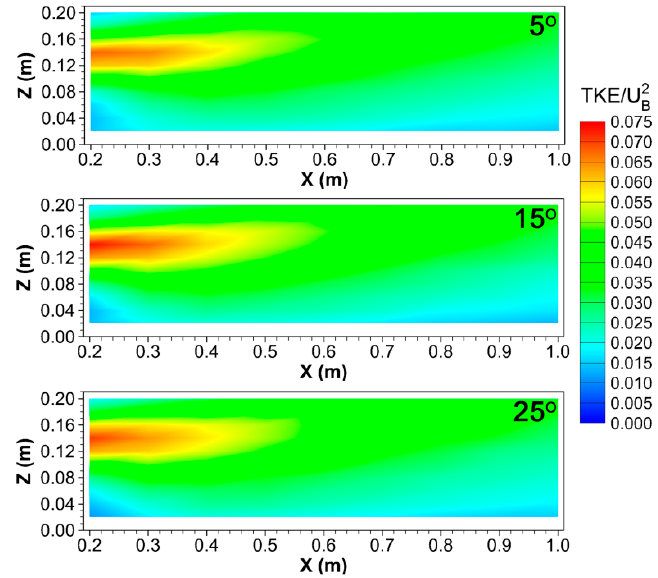
Figure 12. Dimensionless turbulence kinetic energy ( TKE / U B 2 ) distributions at Plane 3 for roof slopes of 5°, 15°, and 25°.